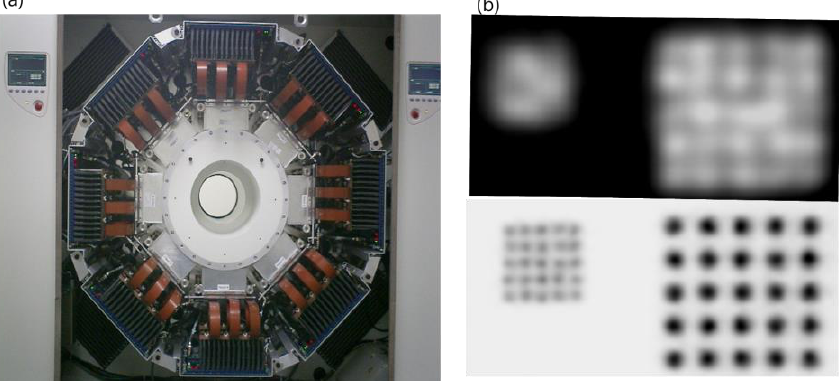
Figure 2. ( a ) HRRT-PET system. ( b ) The resolution of the phantom image obtained from conventional PET – CT (upper) and HRRT-PET (lower) with a 2 mm diameter radioisotope bar separated by 4 mm. Conventional PET – CT has a resolution of < 5 mm FWHM [34], while HRRT images have a resolution of 2.5 mm FWHM.